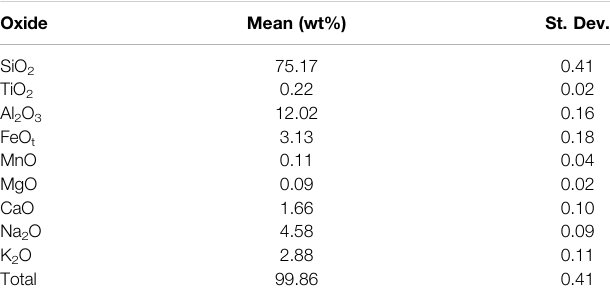
TABLE 1 | Glass chemical composition of our starting material, determined by electron probe microanalysis by Tuffen and Castro (2009). The mean and standard deviation were computed from 100